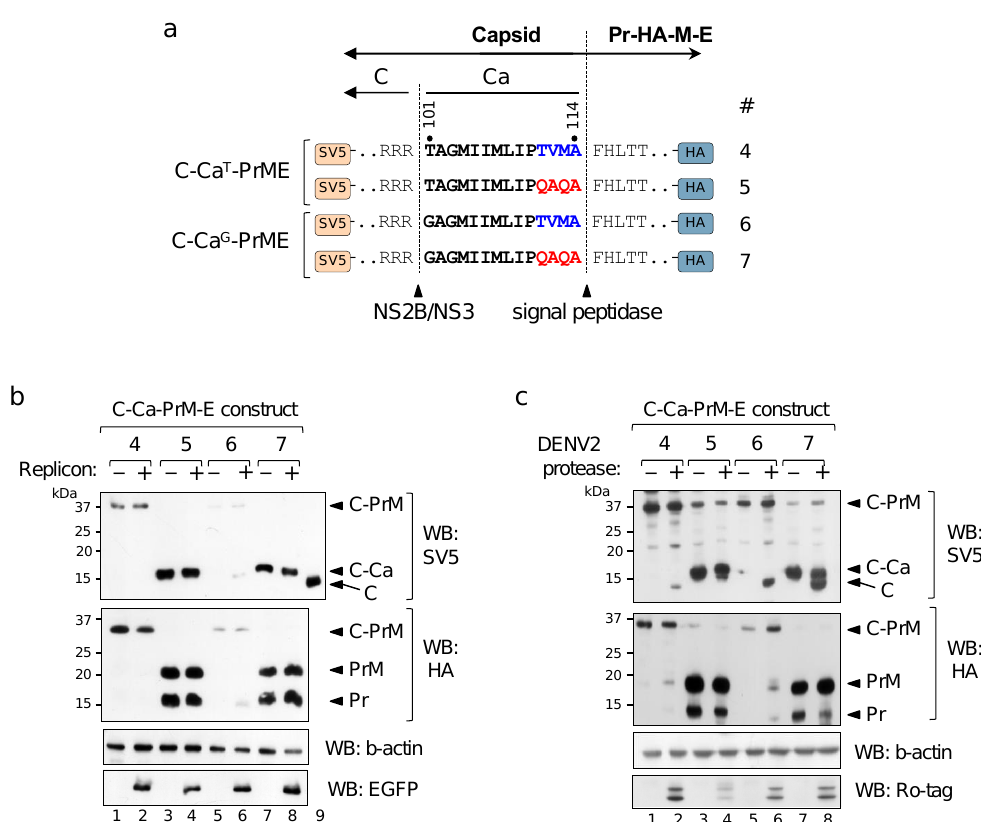
Figure 3. Uncoupling sequential processing. ( a ) Schematic representation of the C-Ca-PrME packaging constructs with wild-type (TVMA) or mutated (QAQA) Ca (numbered 4–7) and tagged with SV5 at the N-terminus of C and with HA at the C-terminus of Pr. Cleavage sites of NS2B / NS3 and signal peptidase are indicated. ( b ) Western blot of cellular extracts of cells co-transfected with the indicated constructs and with ( + ) or without ( − ) WNV replicon, revealed with anti-SV5 (upper panel) and with anti-HA (bottom panel). Replicon expression was controlled with anti-EGFP.Lane 9 corresponds to cells transfected with a construct encoding only C and included as a marker of migration of the mature C protein. Panel ( c ) is the same as ( b ) with ( + ) or without ( − ) DENV2 NS2B / NS3 protease. Expression of DENV2 NS2B / NS3 protease was controlled with anti-Ro - tag. β -actin was used as the loading control.